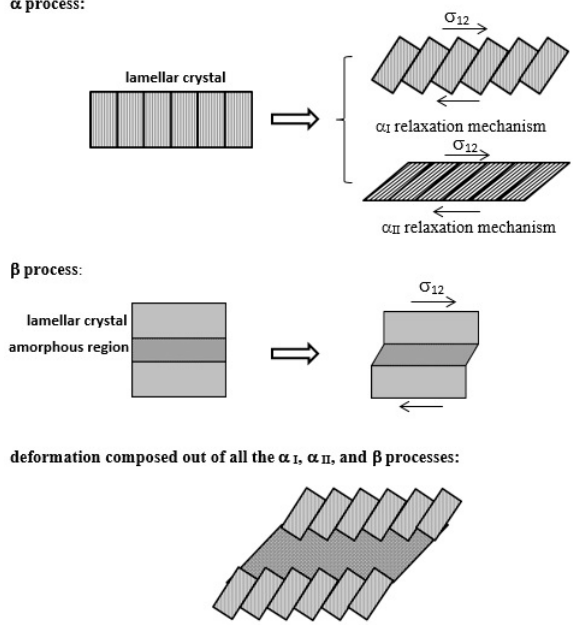
Figure 8. Schematic representation of three types of deformation in polyethylene. From top to bottom: the intermosaic block deformation ( α I ), the interlamellar c-axis shear deformation ( α II ), the interlamellar deformation ( β ), and the deformation composed of all α I , α II , and β processes [61].